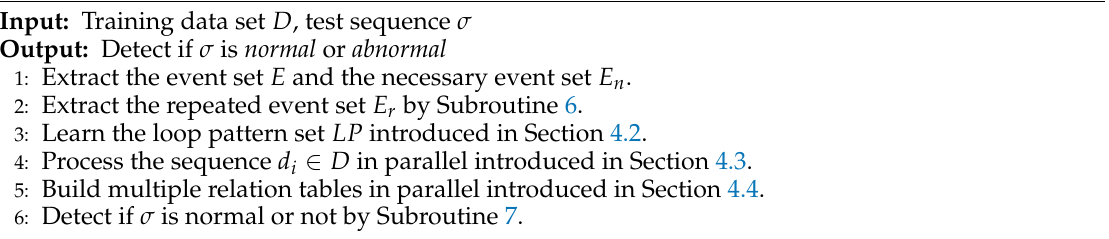
Algorithm 2 Parallel Pattern Relation Table